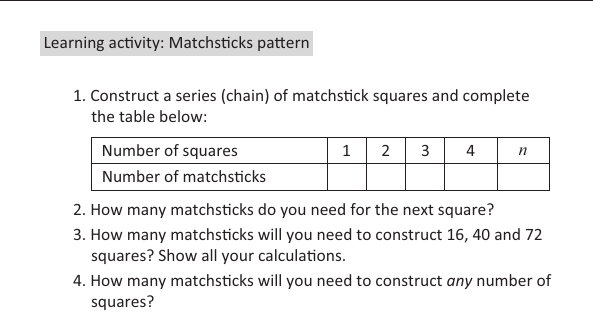
FIGURE 2: Matchsticks pattern